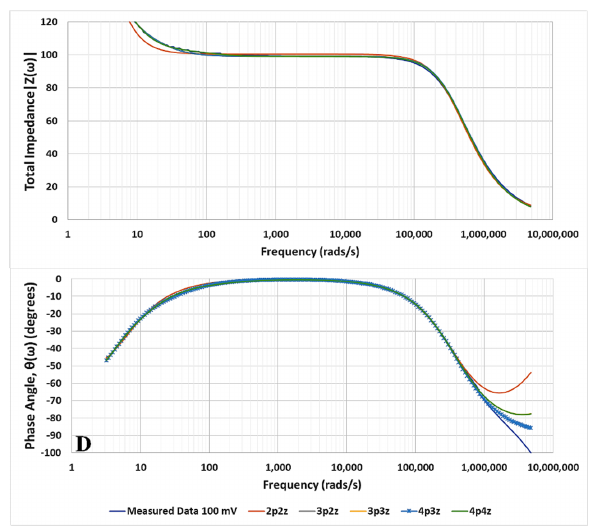
Figure 9. Summary of test results for ( A ) Ranitidine, ( B ) Metamizole, ( C ) Ambroxol, ( D ) Trimethoprim/Sulfamethoxazole and comparison with state-space fitting model derived from frequency-domain impedance data in the frequency range 20 Hz–30 MHz. Table 7. Summary of results: best feasible estimated electrochemical cell.